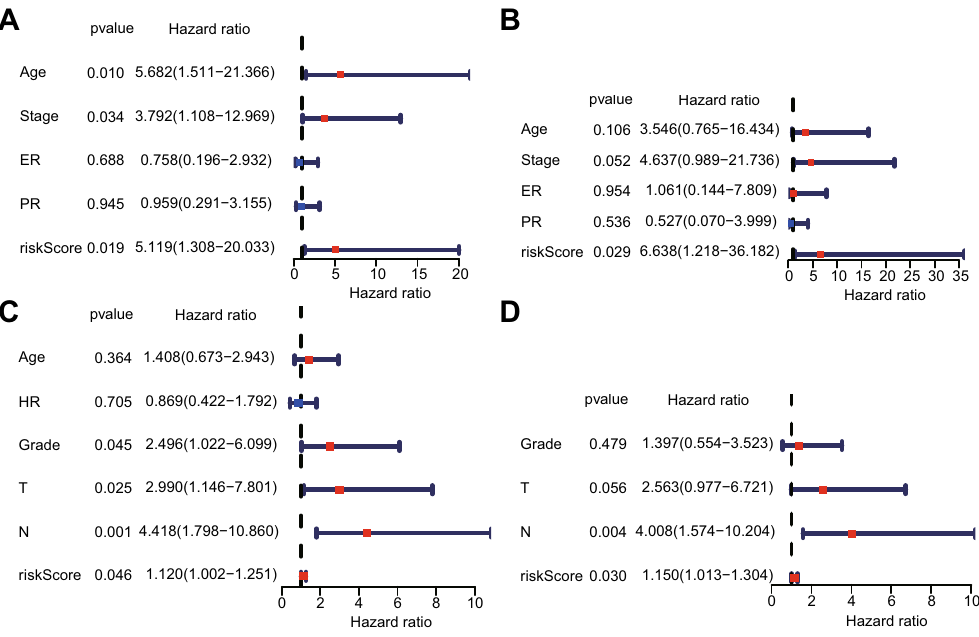
Figure 3. The results of the univariate and multivariate Cox regression analyses. In the training cohort, the forest plots for univariate Cox regression analysis ( A ) show that risk score (high risk vs. low risk), AJCC stage (stages I vs. II, III and IV) and age (< = 50 vs. > 50) were prognostic risk-related variables. The forest plots for multivariate Cox regression analysis ( B ) show that the risk score (high risk vs. low risk) was an independent prognostic factor. In the validation cohort, the forest plots of univariate Cox regression analysis( C ) and multivariate Cox regression analysis ( D ) indicated that the risk score (high risk vs. low risk) was an independent prognostic